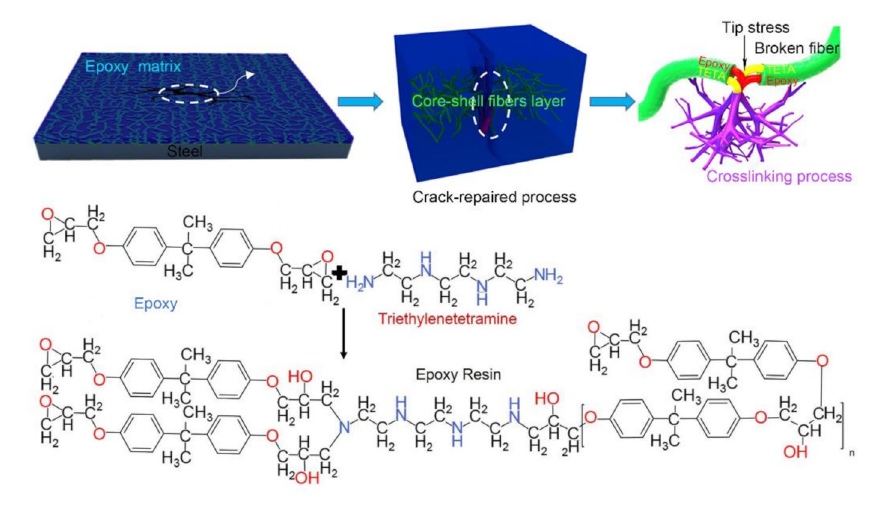
Figure 8. Self-healing schematic of cracks in the multiple-chamber, core-shell nanofiber. The red fiber encapsulates the healing agent, while the green fiber encapsulates the curing agent.